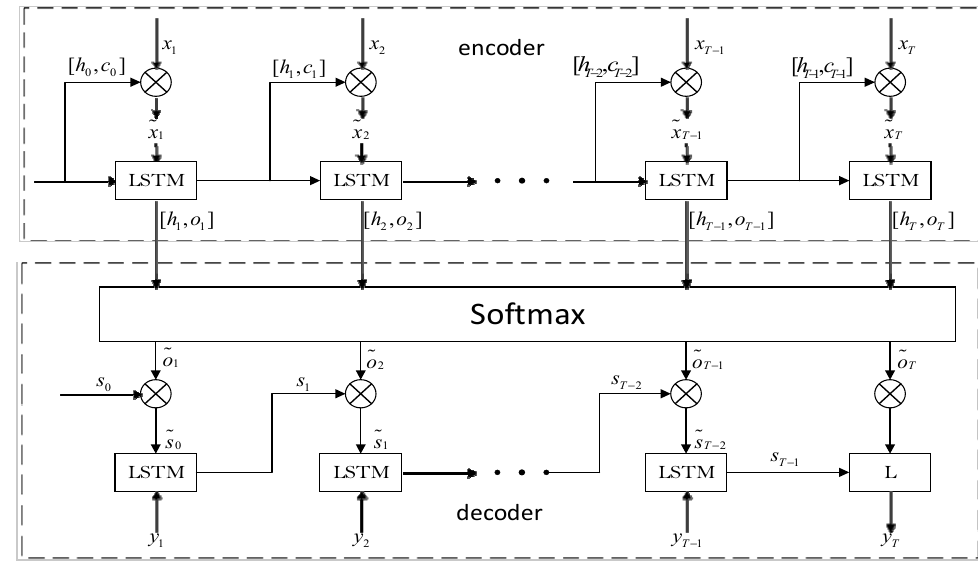
Figure 3. Wind power prediction